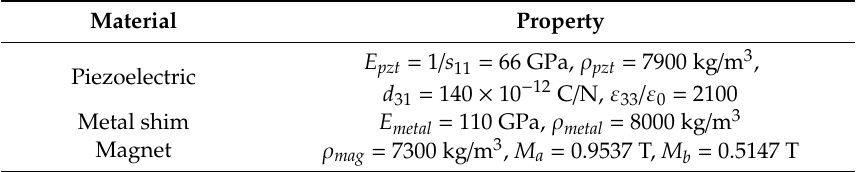
Table 2. The material properties used in the model.